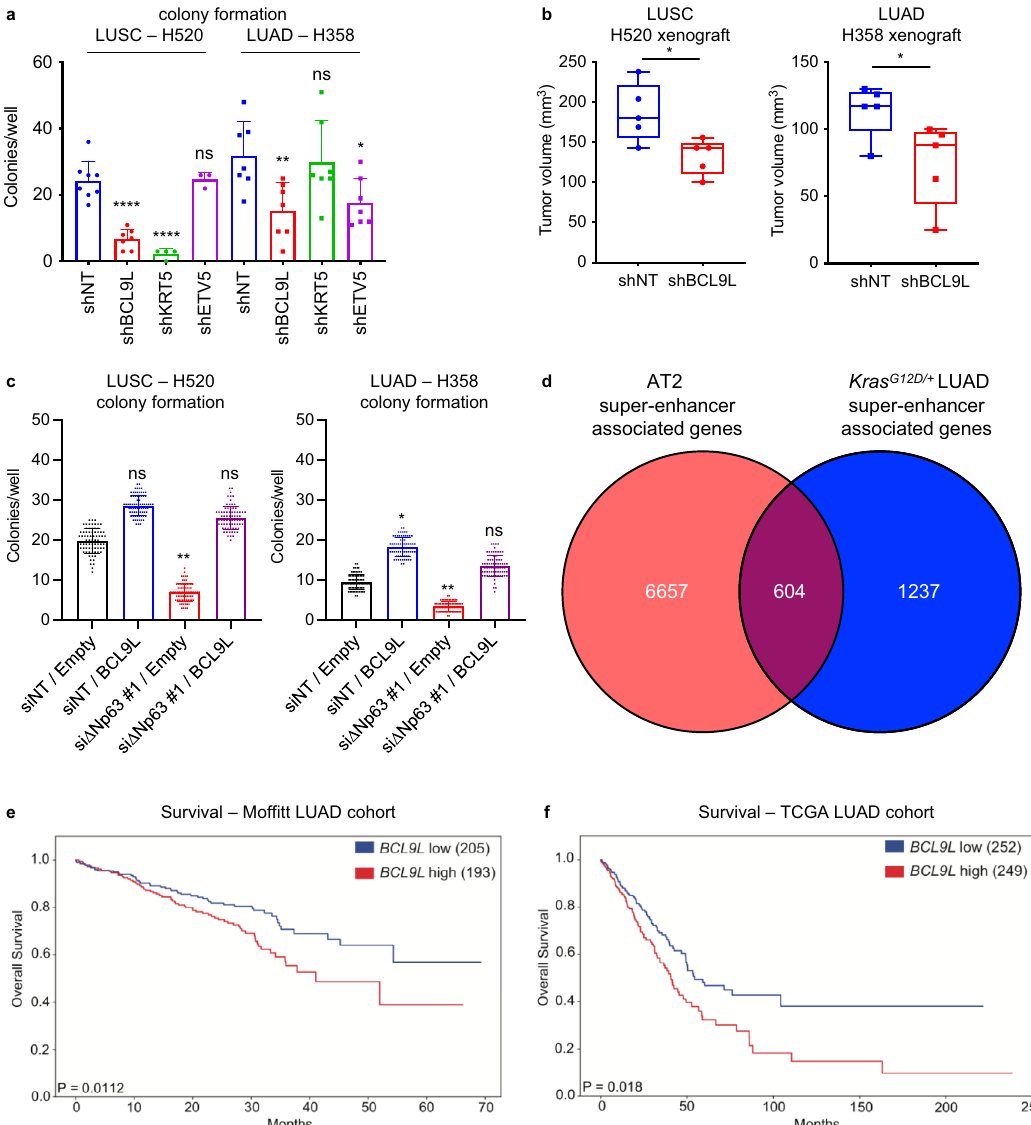
Fig. 8 BCL9L mediates the oncogenic activities of Δ Np63 and is critical for maintenance of LUSC and LUAD. a Quanti fi cation of colony formation ef fi ciency in soft agar of H520 LUSC cells and H358 LUAD cells infected with the indicated shRNAs. Data were mean ± SD, n = 3, * P < 0.05, ** P < 0.01, **** P < 0.0001, vs. respective shNT, two-tailed Student ’ s t- test. b Tumour volume quanti fi ca t ion of xenograft tumours derived from the indicated cell lines. Boxplots represent the individual data points, median and whiskers (min to max method) are shown, n = 5, * vs. respective shNT, P < 0.05, two-tailed constructs. Boxplots represent the individual data points, median and whiskers (min to max method) are shown, n = 3, * P < 0.05, ** P < 0.01, vs. respective siNT/empty, two-tailed Student ’ s t -test. d Venn diagram overlaying genes associated with the top 2000 enhancers in AT2 cells and LUAD derived from Kras G12D/ + mice. e , f Kaplan – Meier curves of overall lung adenocarcinoma survival data based on the levels of BCL9L in the indicated cohorts. Source